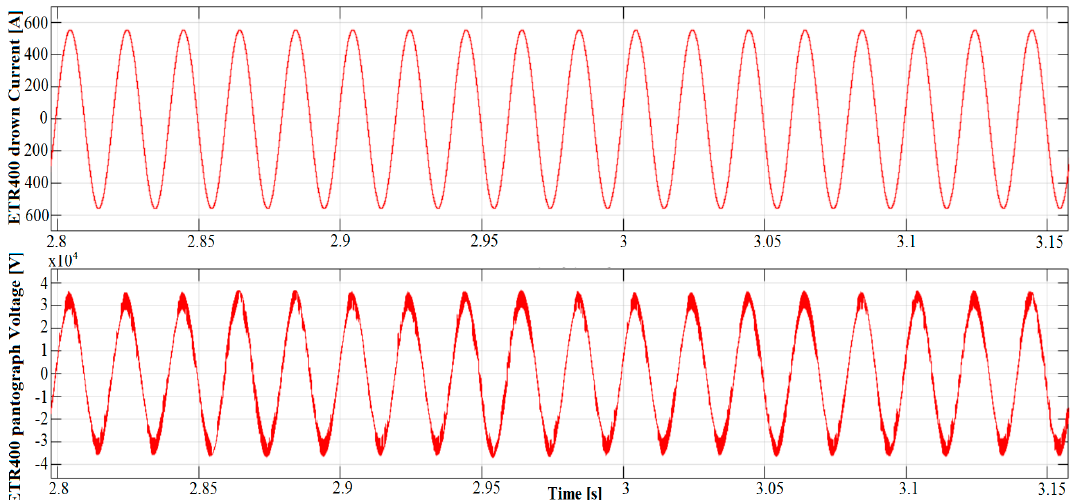
Figure 16. Voltage on the train position and current drawn by the train.